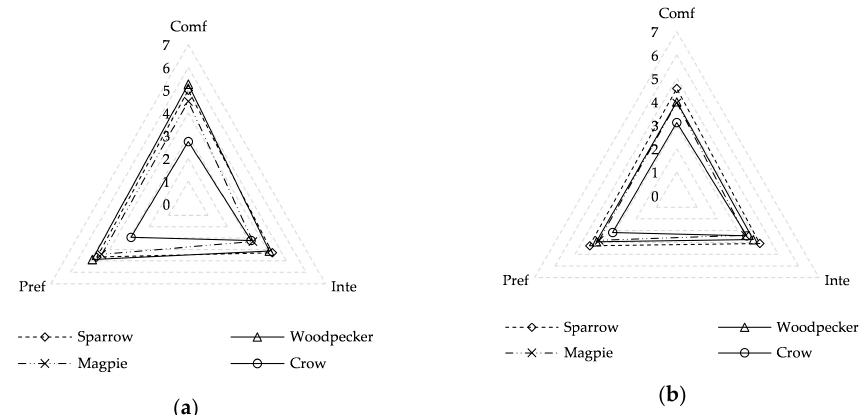
Figure 2. Mean values of sound comfort (Comf), perceived intensity (Inte), and preference (Pref) for different birdsongs in different seasons: ( a ) summer; ( b ) winter.